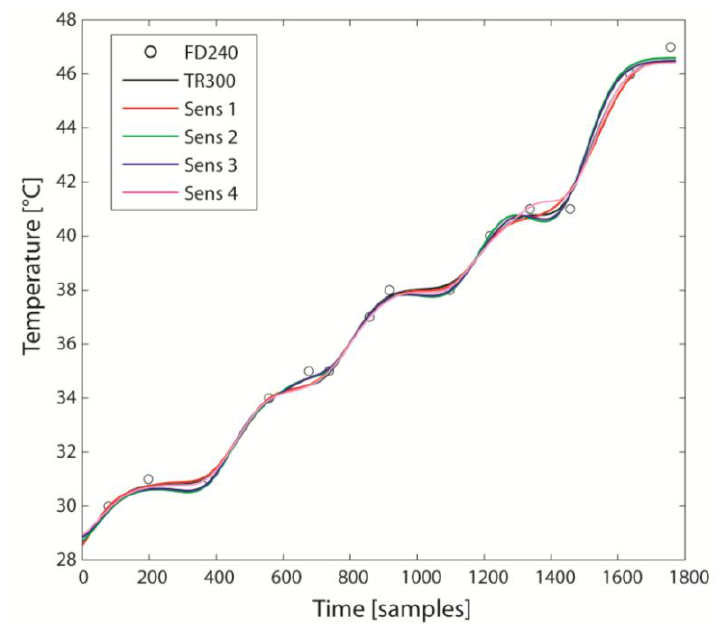
Figure 3. Temperature data after sensor-specific calibration (bias compensation). See Figure 2b for the same data before calibration.